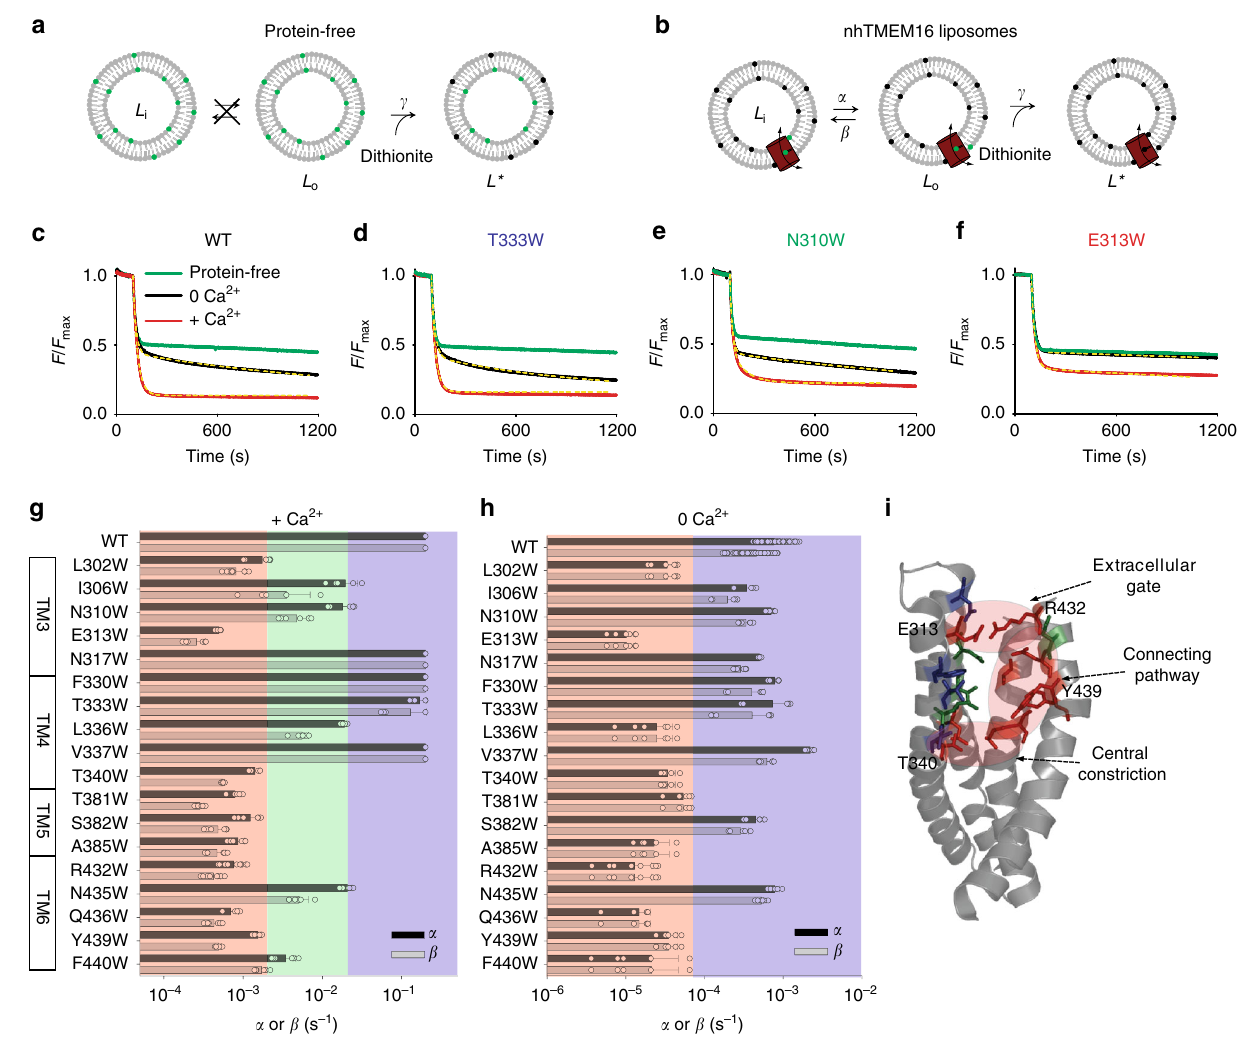
Fig. 2 Effects of W-scanning on scrambling activity of nhTMEM16. a , b Schematic representation of the scrambling assay for protein-free vesicles ( a ) and proteoliposomes ( b ). c – f Representative traces of the dithionite induced fl uorescence decay for WT ( c ) and low- ( d ), medium- ( e ) and high-impact ( f ) tryptophan mutants of nhTMEM16 in the presence (red) and absence (black) of Ca 2 + . Dashed yellow lines indicate fi ts to Eq. (6). Protein-free traces are shown in green. g , h Quanti fi cation of scrambling rate constants α and β for WT and mutant nhTMEM16 in the presence ( g ) and absence of Ca 2 + ( h ). The effects were categorized into three classes as low- (<10-fold reduction, blue shading), medium- (10 to 100-fold reduction, green shading) and high-impact residues (>100-fold reduction, red shading). Individual data points are shown as empty circles. All data is reported as the mean ± S.D. The number of replicates are indicated in Supplementary Table 1. i Mapping of the tested residues on the nhTMEM16 structure according to their impact on scrambling, colors as in g ,